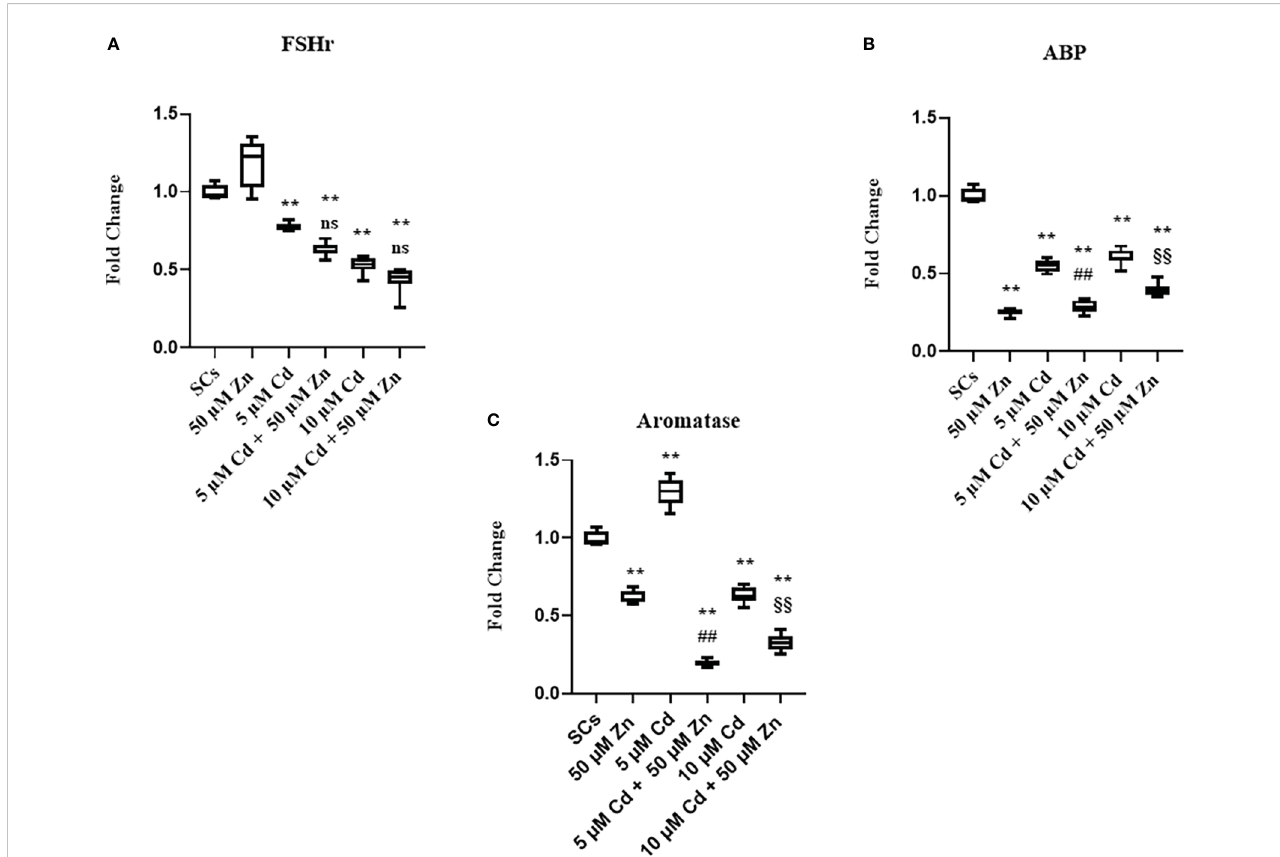
FIGURE 7 Real-time PCR analysis of SC functionality. Gene expression of FSHr (A) , androgen binding protein (ABP) (B) , and aromatase (C) in the absence (unexposed-control group, SCs) or presence of 5 or 10 m M CdCl2 and/or 50 µM ZnCl2 for 48 h. Data presented as the mean ± SEM. (Not signi fi cant, NS). NS vs. SCs, *p < 0.05 and **p < 0.001, #p < 0.05 and ##p< 0.001 vs. 5 µM Cd, §p<0.05, §§p< 0.001 vs. 10 µM, (not signi fi cant, ns) ns vs. 10 µM of three independent experiments, each performed in